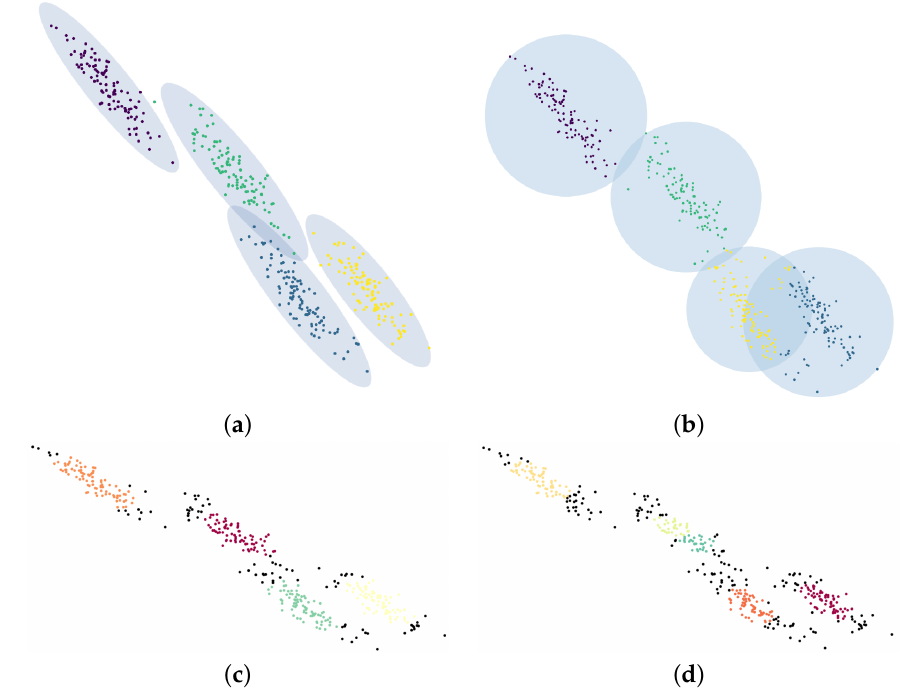
Figure 6. Comparison of clustering results between GMM, K-means and DBSCAN. ( a ) GMM; ( b ) K- means; ( c ) DBSCAN, eps = 0.3, minPts = 20; ( d ) DBSCAN, eps = 0.25, minPts =